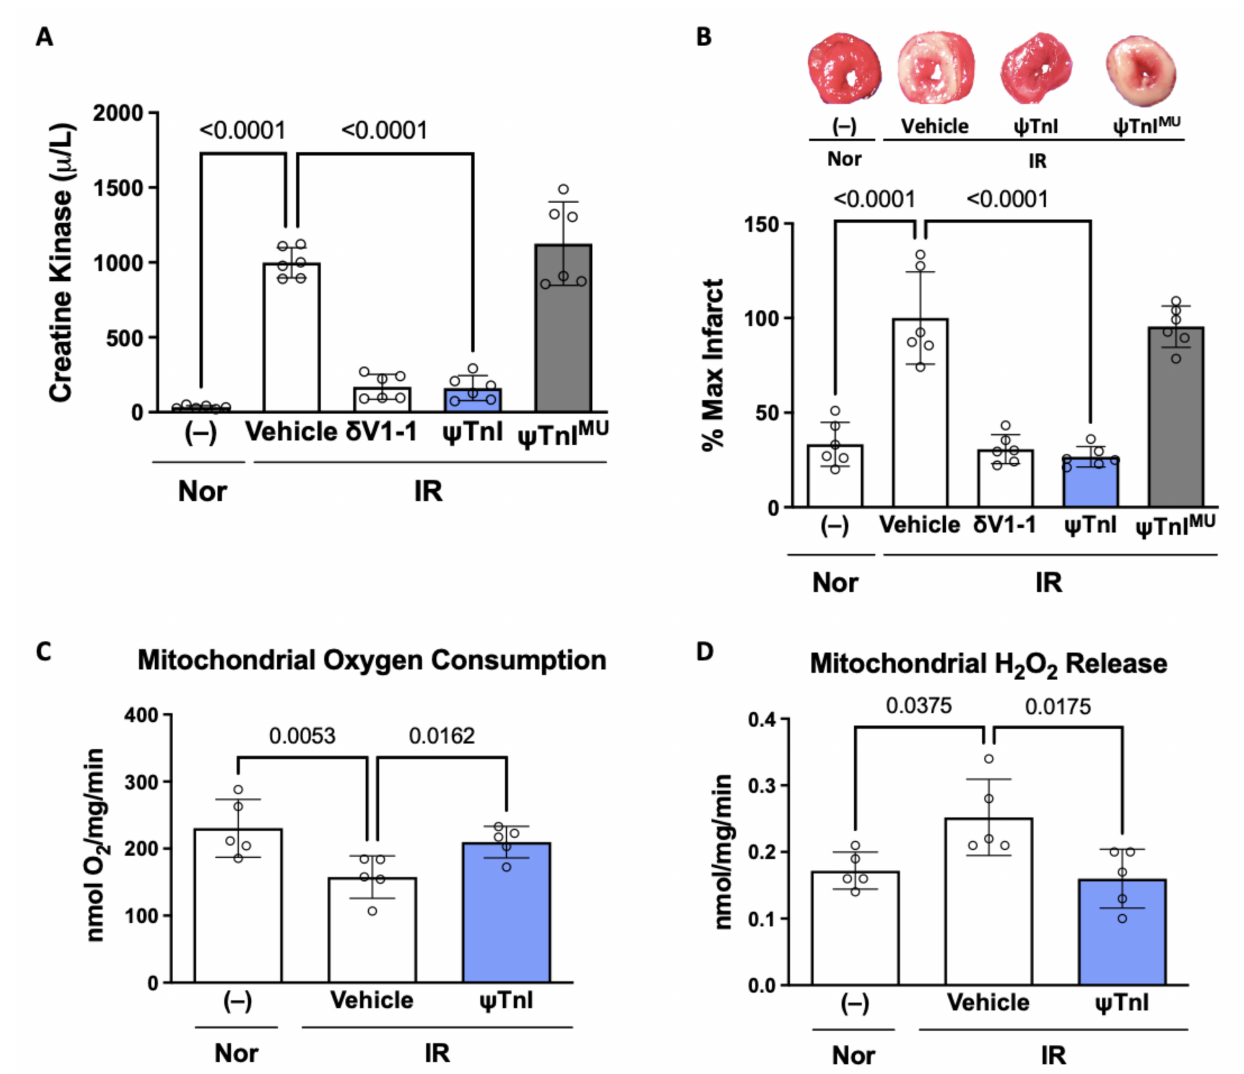
Figure 4. ψ TnI prevents IR-induced cardiac damage and mitochondrial dysfunction. Treatment with ψ TnI attenuates cardiac injury following IR in male rat hearts, similar to the pan- δ PKC inhibitor δ V1-1, while ψ TnI MU , an inactive analog of ψ TnI, does not, as demonstrated by creatine kinase release ( A ) and infarct size ( B ); n = 6/condition. IR-induced mitochondrial dysfunction in male rat hearts was attenuated with ψ TnI treatment at reperfusion, as evidenced by changes in rates of maximal ADP- stimulated (state III) oxygen consumption ( C ) and H 2 O 2 production ( D ); n = 5 biological replicates unless otherwise stated; 1 µ M δ V1-1, TAT, ψ TnI, or ψ TnI MU used. Data were evaluated by one-way ANOVA with Tukey’s multiple comparisons between each treatment group and p <